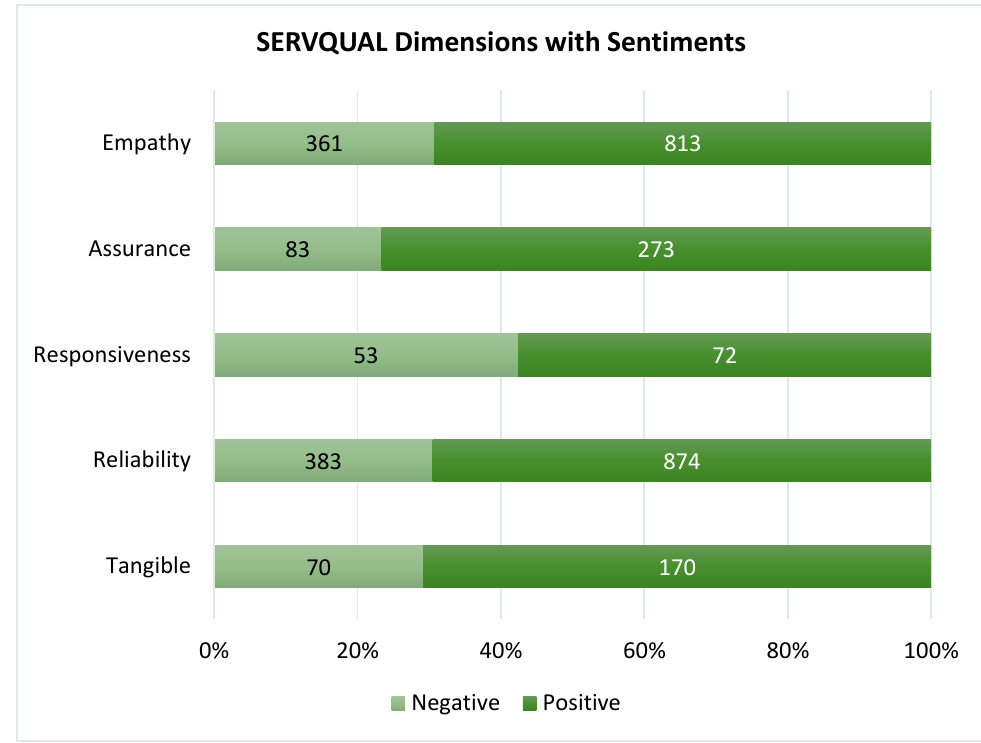
Figure 4. SERVQUAL dimensions with positive or negative sentiment. Table 8. Determinants of positive sentiment using multivariate analysis ( n =